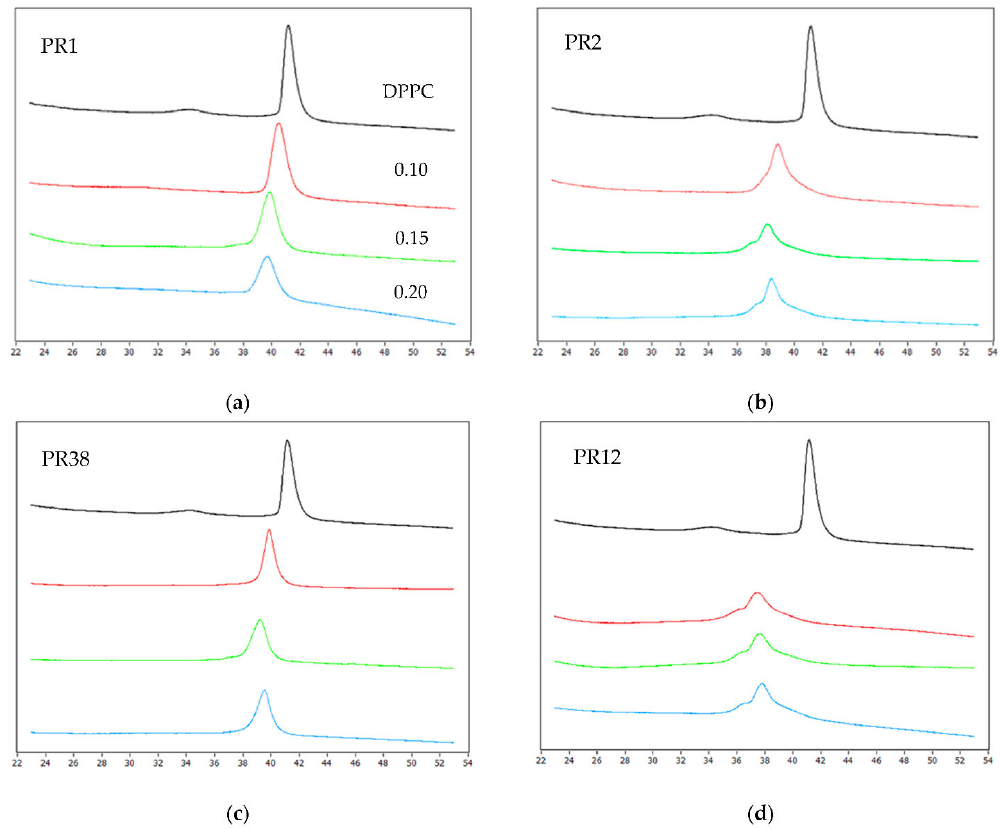
Figure 1. The exemplary thermograms obtained for DPPC mixed with compounds: ( a ) PR1, ( b ) PR2, ( c ) PR38, ( d ) PR12 as well as for pure lipid (the first curve from the top—black color). Curves in the figure represent the thermograms obtained for different compounds. DPPC molar ratios from the top to the bottom: 0 (pure lipid), 0.1, 0.15, 0.2. The addition of the oxicam derivatives caused vanishing of the DPPC pre ‐ transition peak and a concentration ‐ dependent shift of the main transition temperature towards